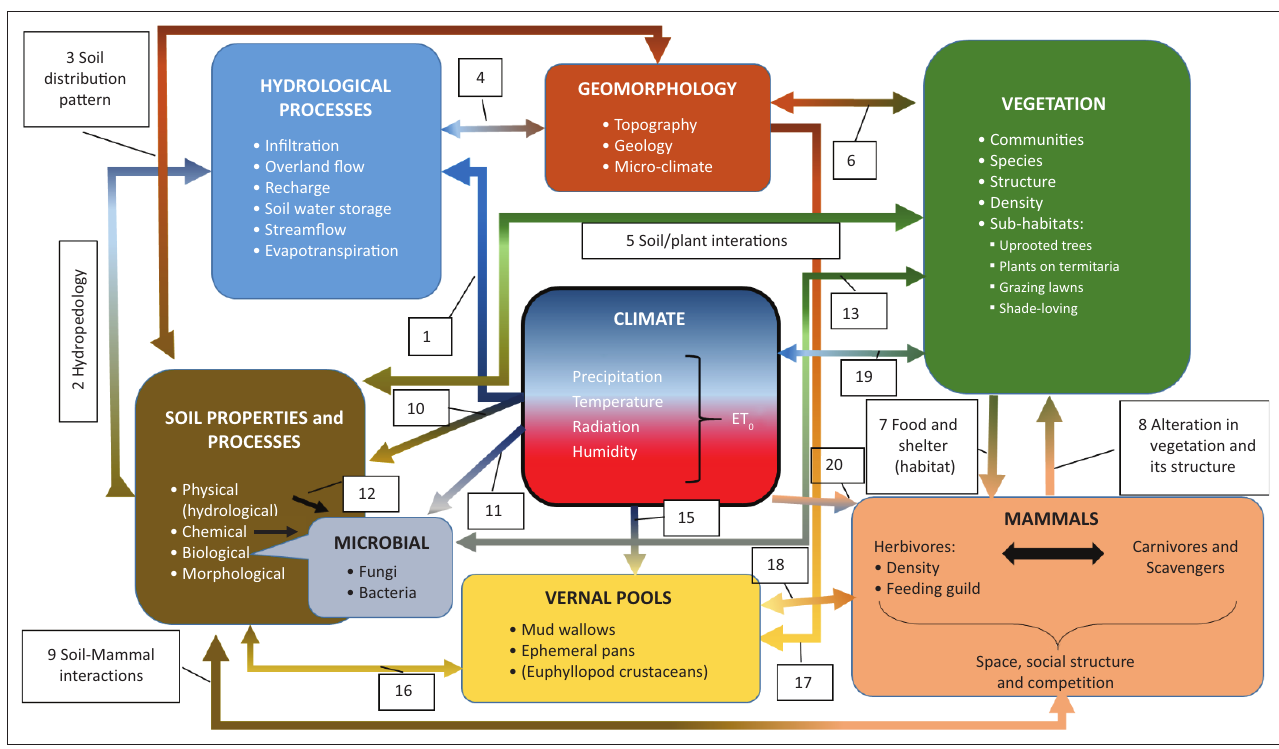
FIGURE 2: Interconnectivity of components that formed part of this study on a granitic catena ecosystem in the